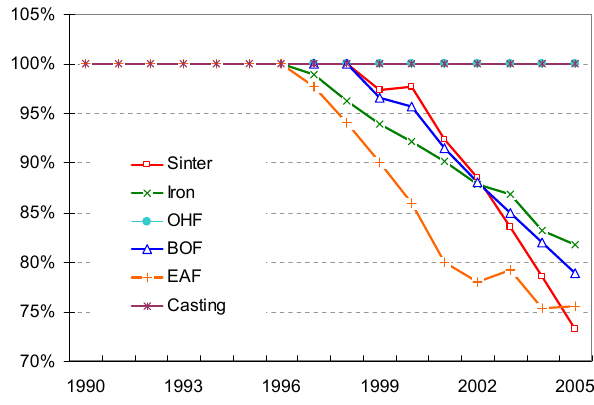
Fig. 2. Trends of net EF of TSP from processes/technologies in iron and steel industry. All data are normalized to the year 1996.